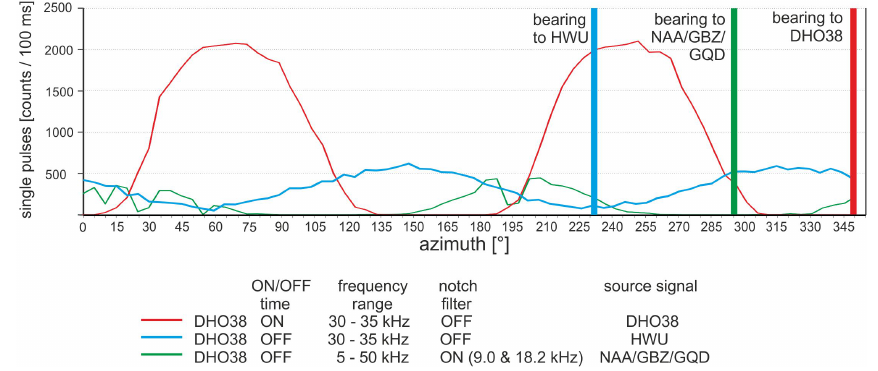
Fig. 10. Validation of the effects of DHO38 intermissions and notch filters. Measurements were carried out close to Frankfurt am Main (Germany). Band-pass filters applied before (red line) and during (blue line) the intermission of DHO38 produce measurement results pointing towards DHO38 and HWU, respectively. Applying a notch filter during the intermission of DHO38 at 18.2kHz and 9kHz causes a switch of the main B EMR towards other VLF transmitters. NAA (USA), GBZ (United Kingdom) and GQD (United Kingdom) represent possible